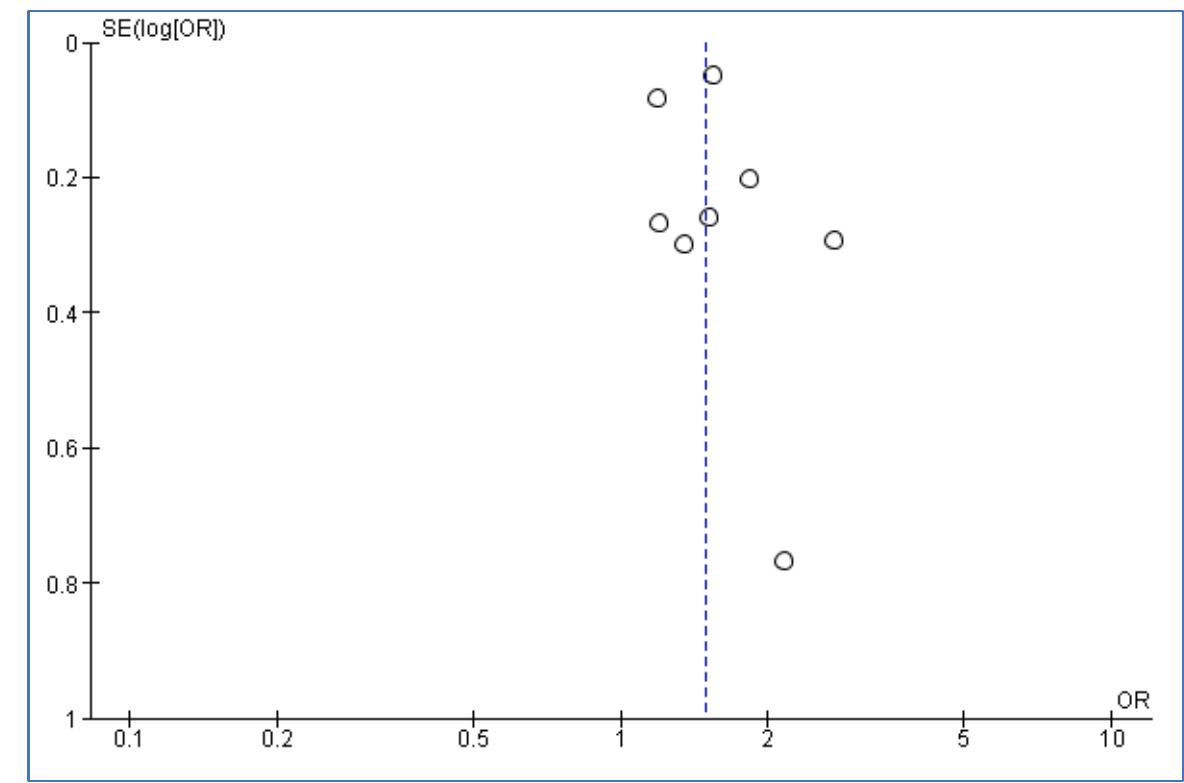
Figure 4. Funnel plot to explore publication bias.